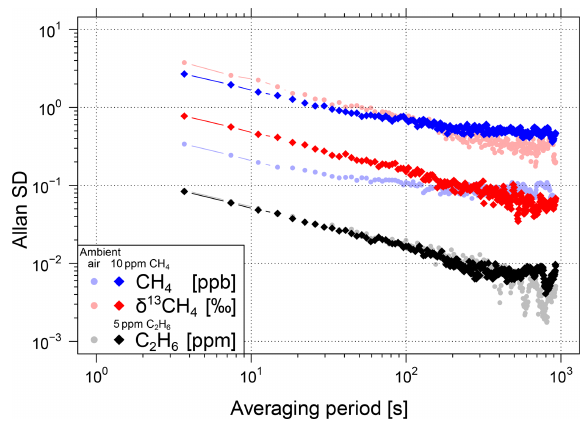
Figure 4. Allan standard deviations of CH 4 , δ 13 CH 4 and C 2 H 6 for two different sample gases each. Results for the first sample gas at atmospheric concentrations are shown in light (red, blue and grey) colours. Results for the second sample gas with 10ppm CH 4 are shown in bright red and blue and for the third sample gas with 5ppm C 2 H 6 in